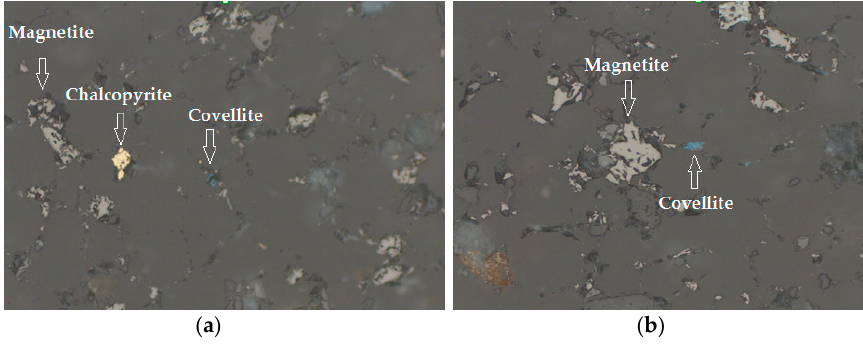
Figure 9. Optical microscope images of solid residue after leaching from ( a ) seawater, and ( b ) water system. Minerals 2018 , 8 , x FOR PEER REVIEW